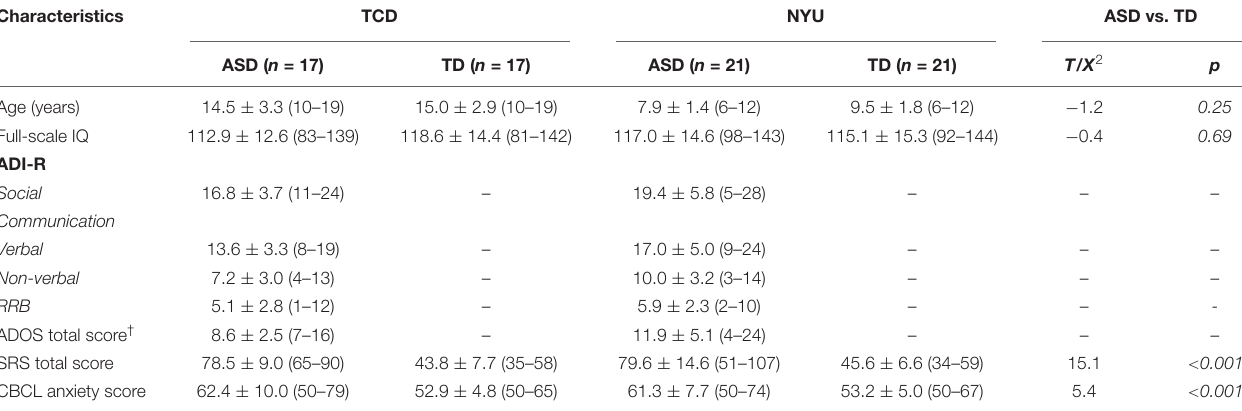
TABLE 1 | Participant demographics and clinical